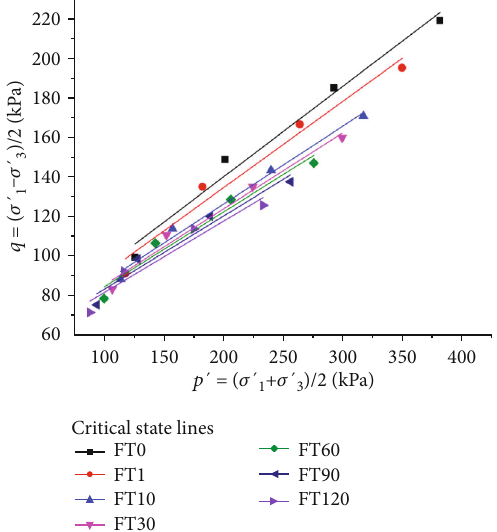
Figure 8: Critical state lines of specimens under di ff erent numbers of freeze-thaw cycles. Table 6: Linear curve- fi tting parameters of critical state lines. Freeze-thaw cycles